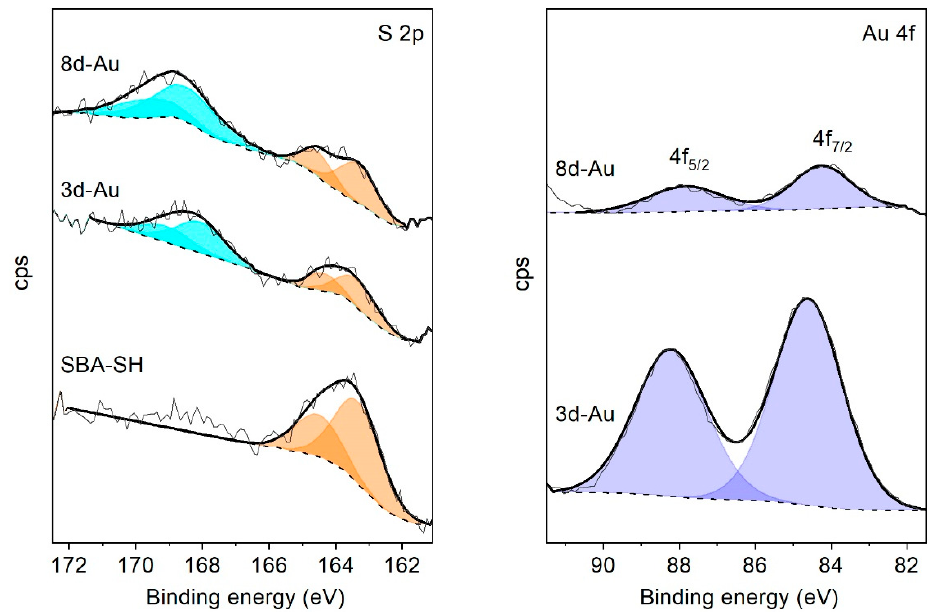
Figure 3. S 2p and Au 4f core-level XPS spectra. Signal intensities were normalized to a constant Si 2p peak area.